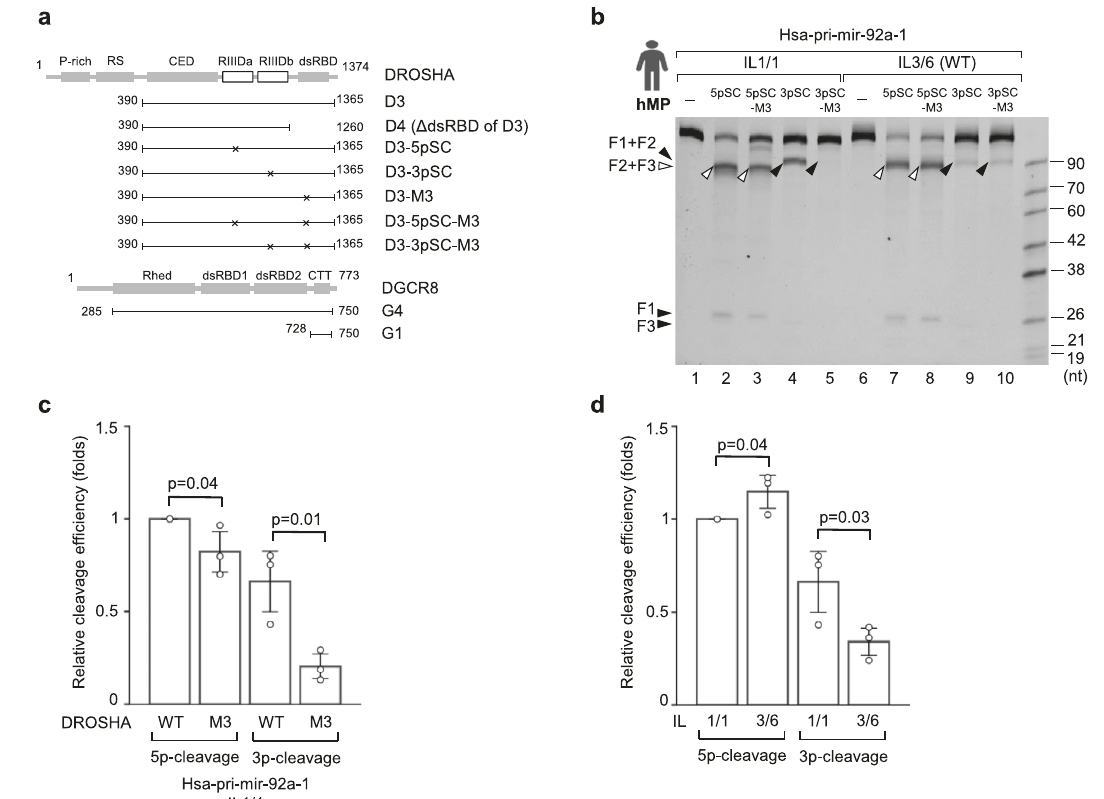
Fig. 5 dsRBD supports the 3p-strand cleavage of animal DROSHAs. a The DROSHA and DGCR8 fragments were puri fi ed and used in this fi gure. The numbers indicate the positions of amino acids at the N- and C-terminus of each protein fragment. The asterisks indicate the mutation sites. Rhed, RNA heme-binding domain; CTT, C-terminal tail. Pri-miRNA cleavage assays. b Five pmol of pri-miRNAs were incubated with 5 pmol of human WT or mutant Microprocessor for 2 h at 37 °C. c , d The cleavage ef fi ciency of the WT and mutant Microprocessor in ( b ). The cleavage ef fi ciency was estimated as the ratio of the F2 + F3 or F1 + F2 to the original substrates. The p -values of the two-tailed t -test for the relative cleavage ef fi ciency estimated from three replicates were shown. The error bars represent SEM. hMP, human